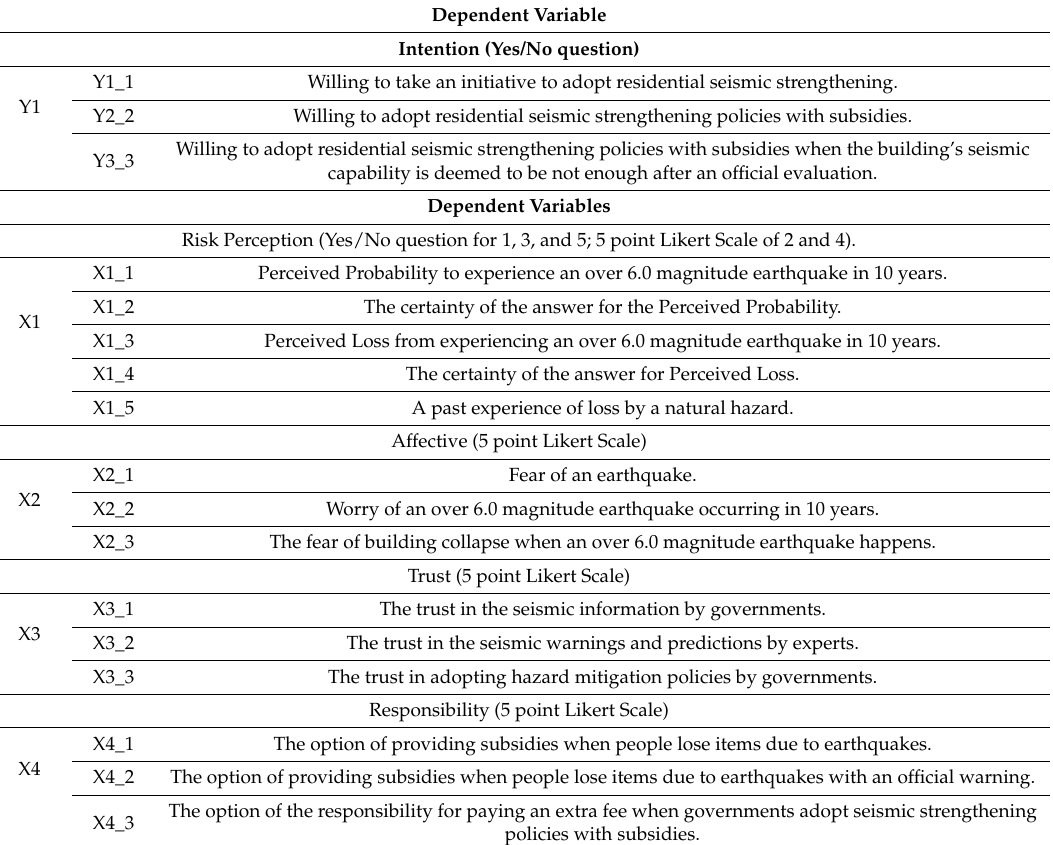
Table 2. The variables of the model in this study.